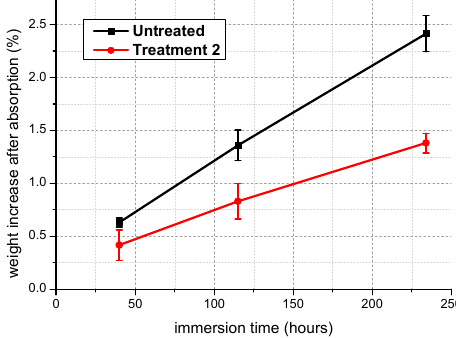
Figure 7. Influence of FA treatments on the water uptake of 0° specimen (error bars indicate standard deviation).